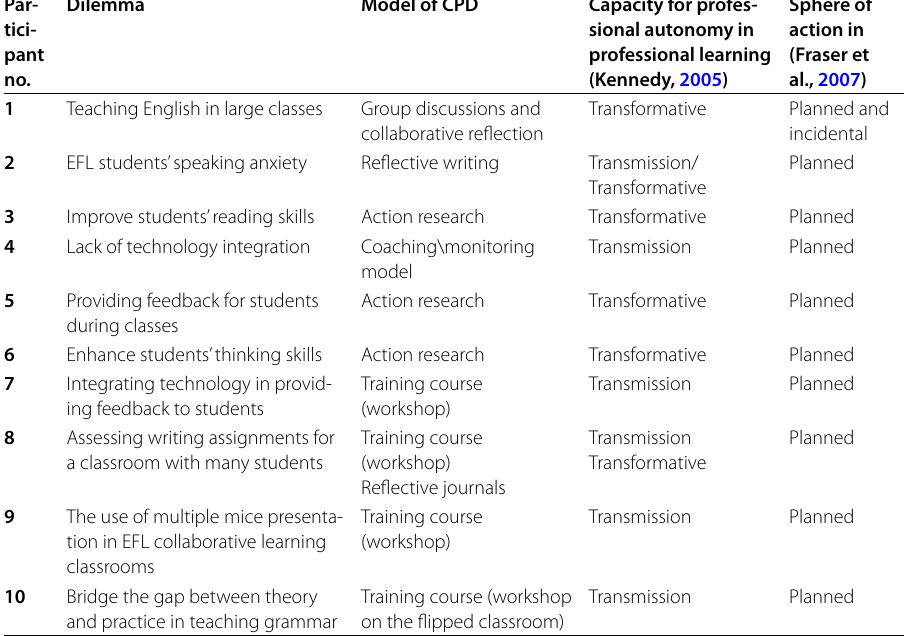
Table 1 EFL student-teachers’ professional development courses Par- tici- pant